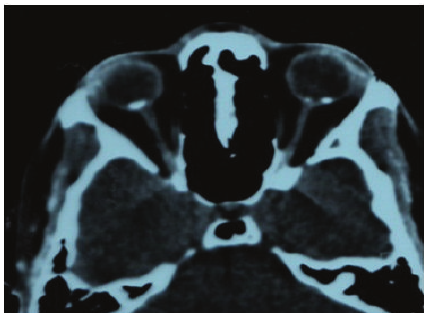
Figure 6: Orbital computerized tomography (CT) scans show hyperdense plaques, with bone-like homogeneity in the posterior pole. Two plaques are seen in the left